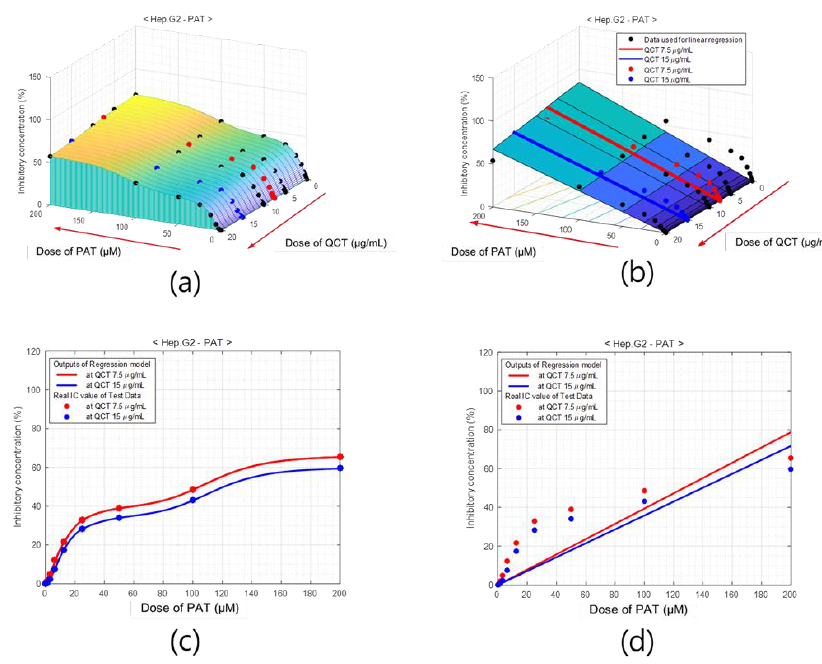
Figure 8. Percentage of inhibition model of QCT for Hep G2 cell with PAT. Surface of % of inhibition obtained using ( a ) ANN model and ( b ) linear regression. Cross-sections of ( c ) ANN-based model and ( d ) linear regression model at QCT = 7.5 μg/mL (red) and QCT = 15 μg/mL (blue), which comprise the test area.